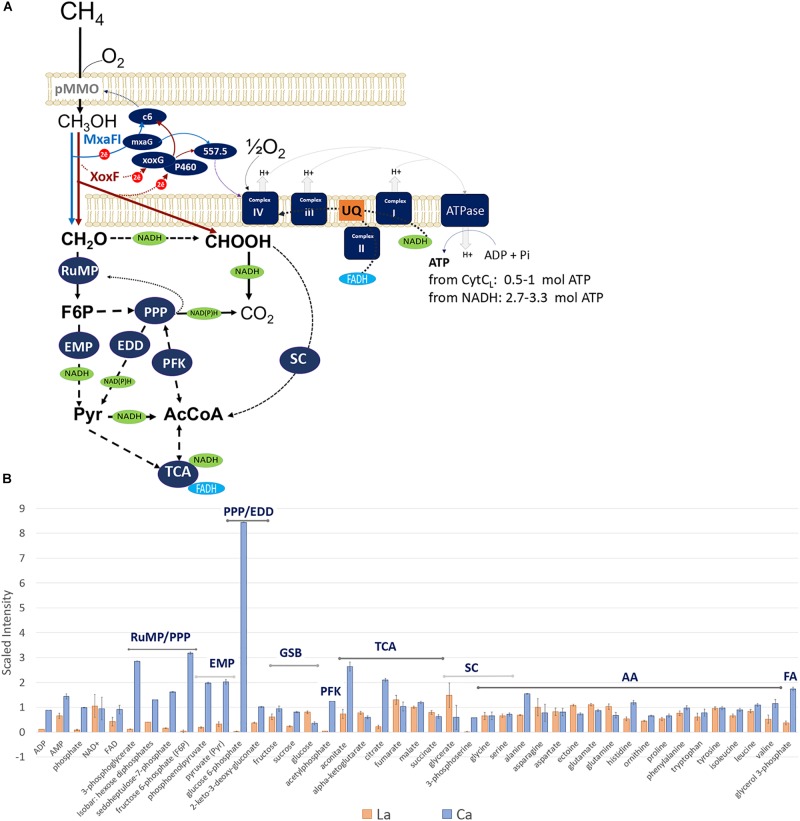
(A) Central metabolic pathways of M. alcaliphilum 20ZR. All abbreviations of metabolic pathways and enzymes are presented in the main text. (B) Compounds detected in cells grown with La (red) or Ca (blue).